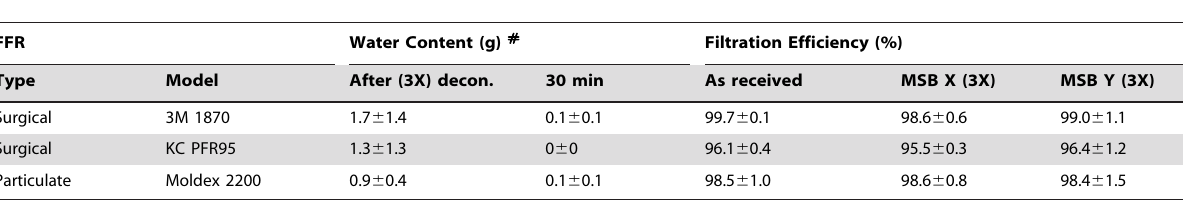
Table 2. Phase 2 testing for water absorbency and filtration efficiency.